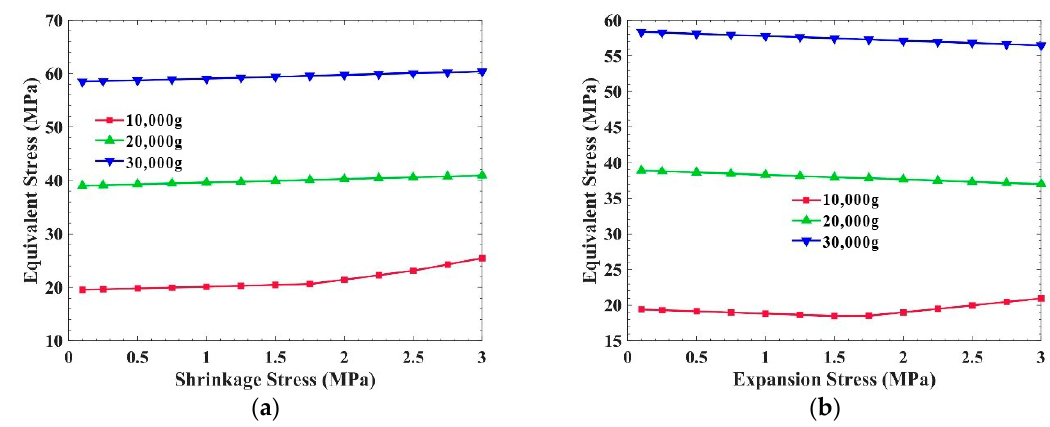
Figure 9. Influence of the internal stress of the potting adhesive on the equivalent stress of the PCB, which is parallel to the overload direction: ( a ) Shrinkage stress; ( b ) Expansion stress.